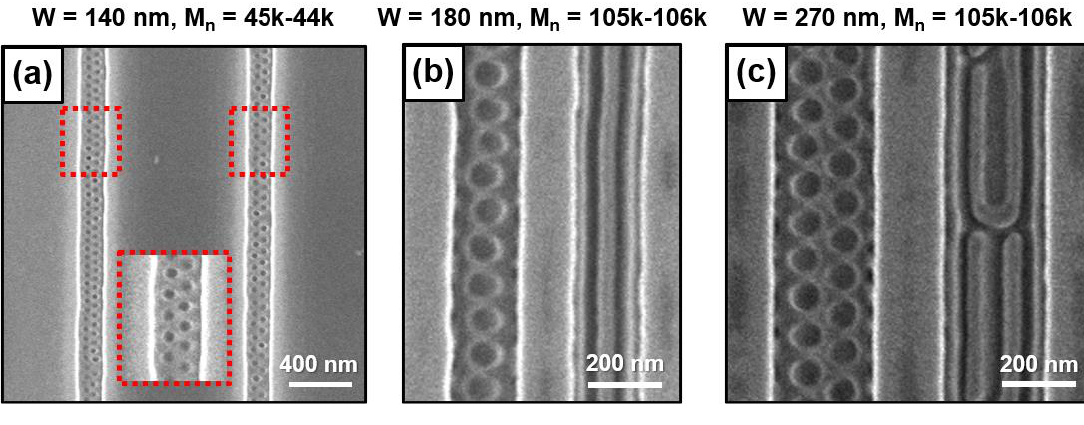
Figure 5. ( a ) Top-view SEM image of the surface-perpendicular pseudocylindrical nanodomain ( C 丄 ) on the trench area and the surface-parallel lamellar nanodomain on the mesa area (PS- b -PMMA, 44 – 45 kg/mol, W = 140 nm). ( b – c ) Surface-perpendicular pseudocylindrical nanodomain ( C 丄 ) and the sidewall-parallel lamellar nanodomain (L ║ ) in the trench area (PS- b -PMMA, 105 – 106 kg/mol, W = 180 and 270 nm).